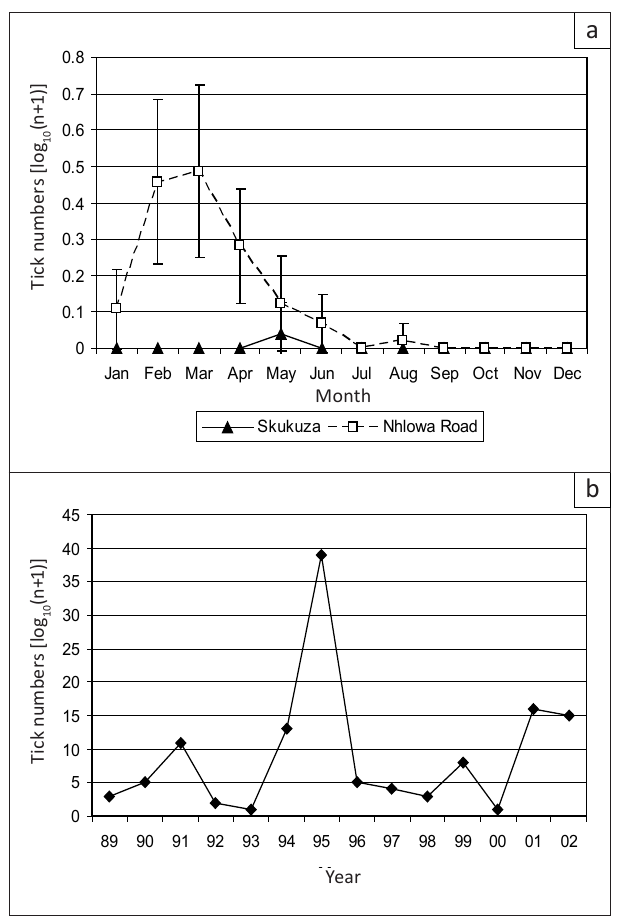
FIGURE 6: (a) Mean collections (± 95% confidence interval) of Rhipicephalus turanicus adults by month at the two sites and (b) total collections by year at Nhlowa